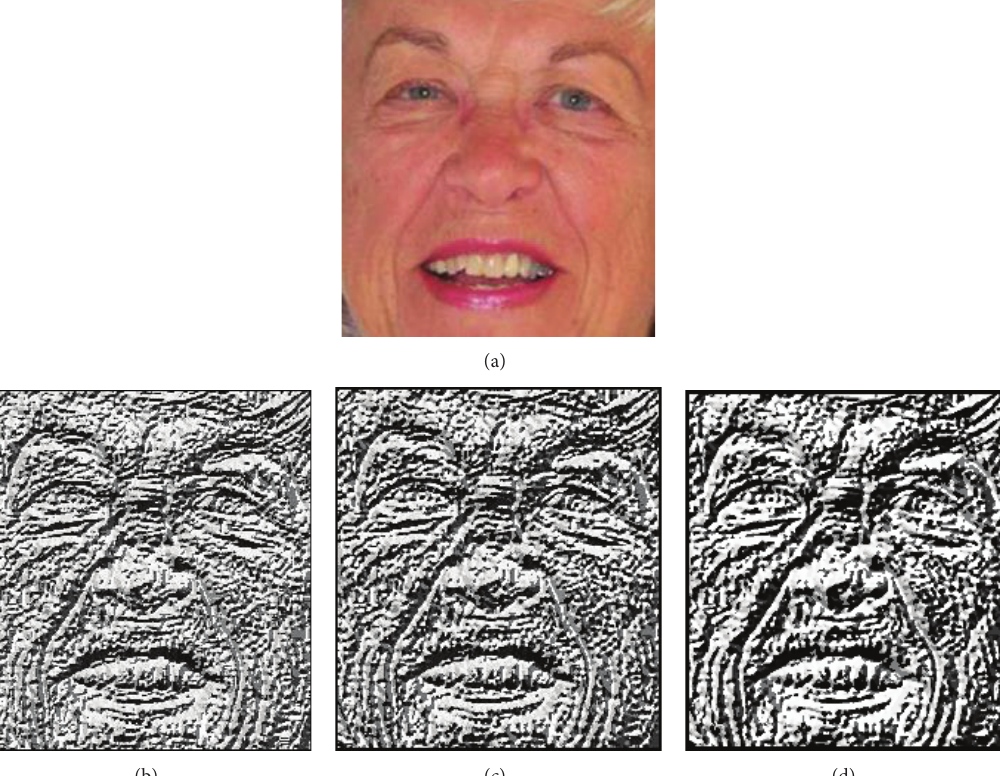
Figure 5: Example of texture extraction by LBP method at different values of 𝑅 and 𝑃 : (a) an example facial image, texture extraction by LBP operator with (b) 𝑅 and 𝑃 of 1 and 8, respectively, (c) 𝑅 and 𝑃 of 2 and 8, respectively, and (d) 𝑅 and 𝑃 of 3 and 12, respectively.